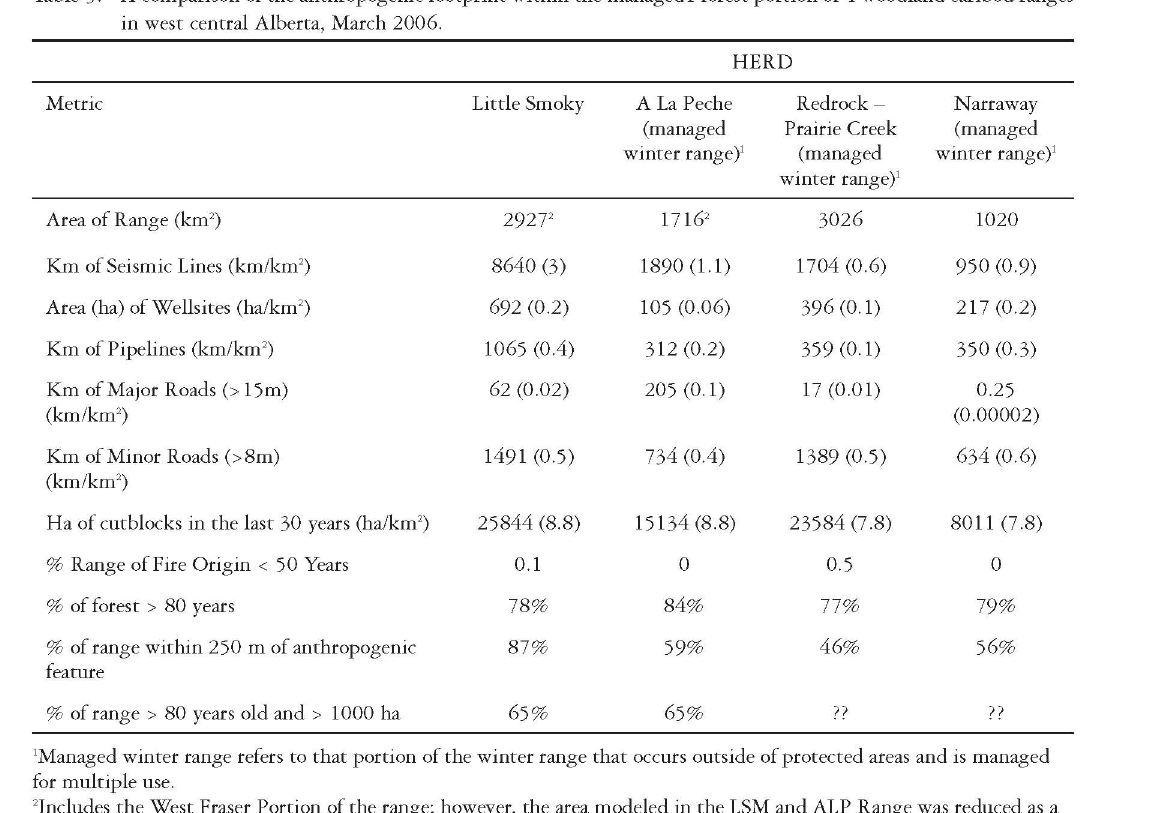
Table 4. Modified GIS avoidance buffer parameters 1